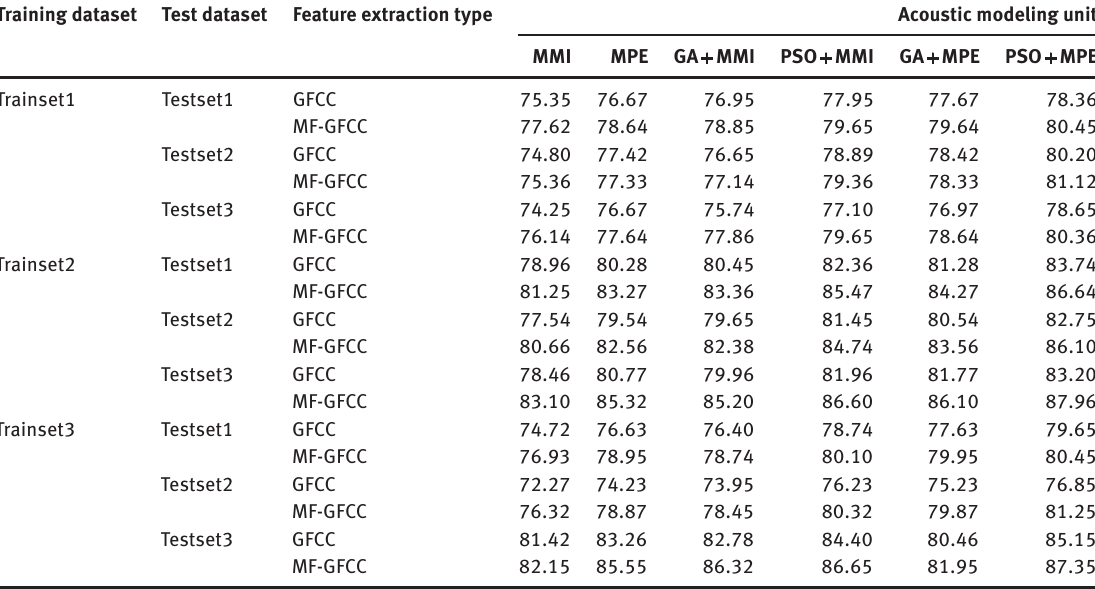
Table 3: Comparative Analysis Using Refined Features and Discriminative Methods. Training dataset Test